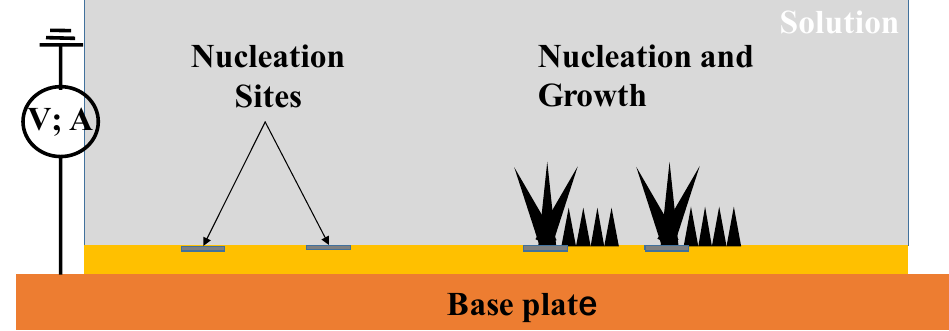
Figure 2. A schematic view on the electrochemical procedure with the use of electric field.